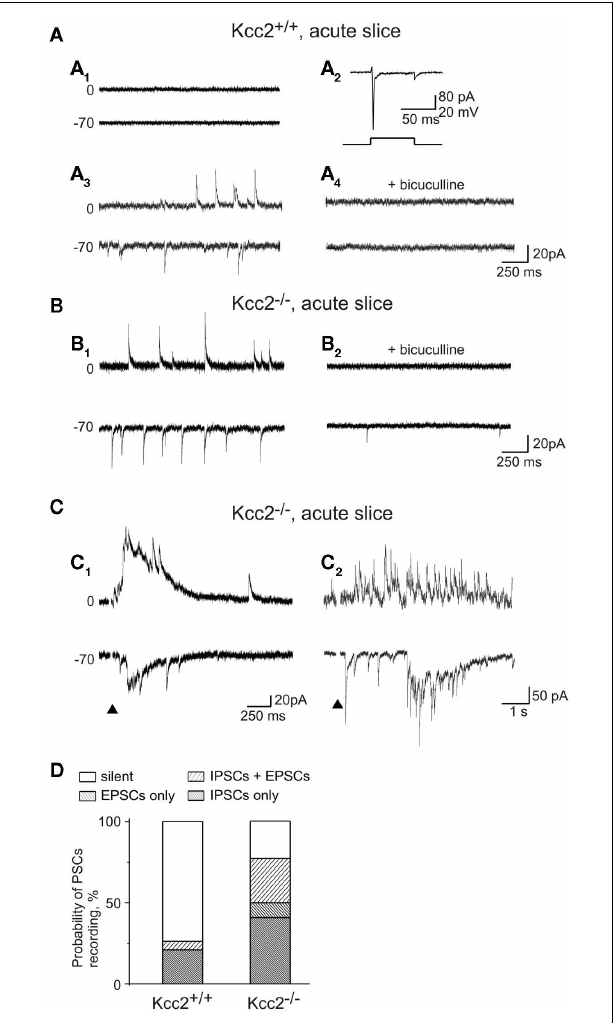
change of the network properties in embryonic Kcc2 − / − hip- pocampiandinepileptictissueisanimportantsubjectforseparate study.